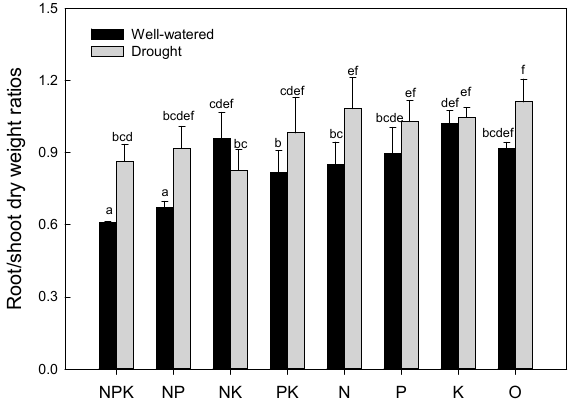
Figure 7. Interactive effects of drought and the N, P and K nutrients applied individually or in combination, or with no nutrient application (0) on the root/shoot dry weight ratios of the maize seedlings at day 20 after sowing. The error bars represent the standard errors of the mean ( n = 3) and fit within the plot symbol if not visible. Means accompanied by different letters are significantly different at p < 0.05.